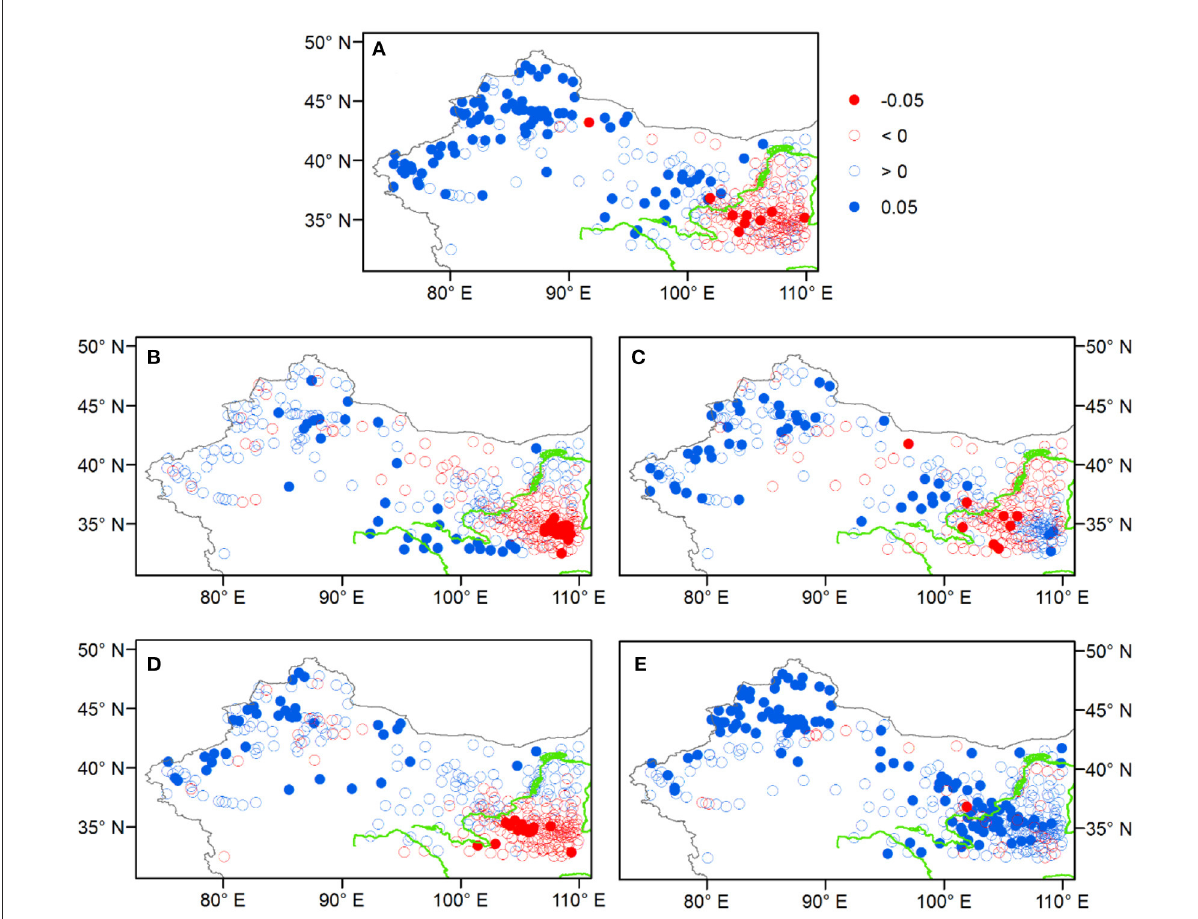
FIGURE3 Variation distribution of change trends to precipitation over Northwest China [blue/red solid circles denote obvious increase/decrease; blue/red hollow circles denote no obvious increase/decrease; (A) annual, (B) spring, (C) summer, (D) autumn, (E) winter] (Wu et al., 2019).